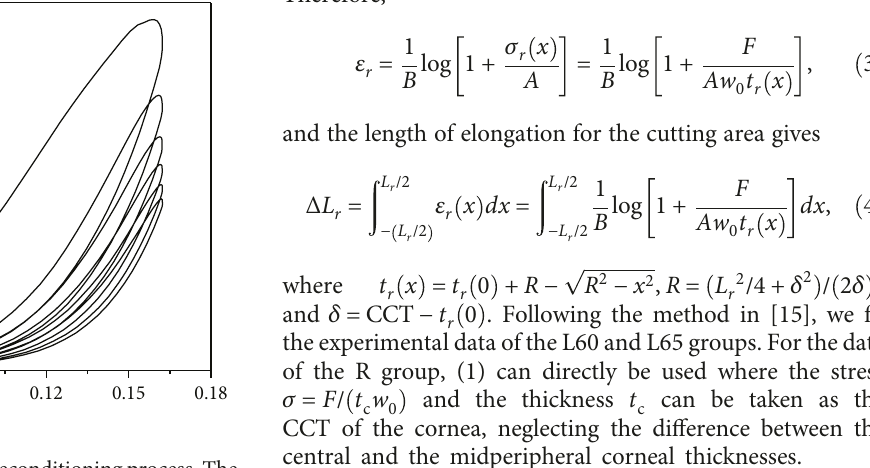
Figure 4: Stress-strain data during the preconditioning process. The hysteresis loop decreases with succeeding cycles.